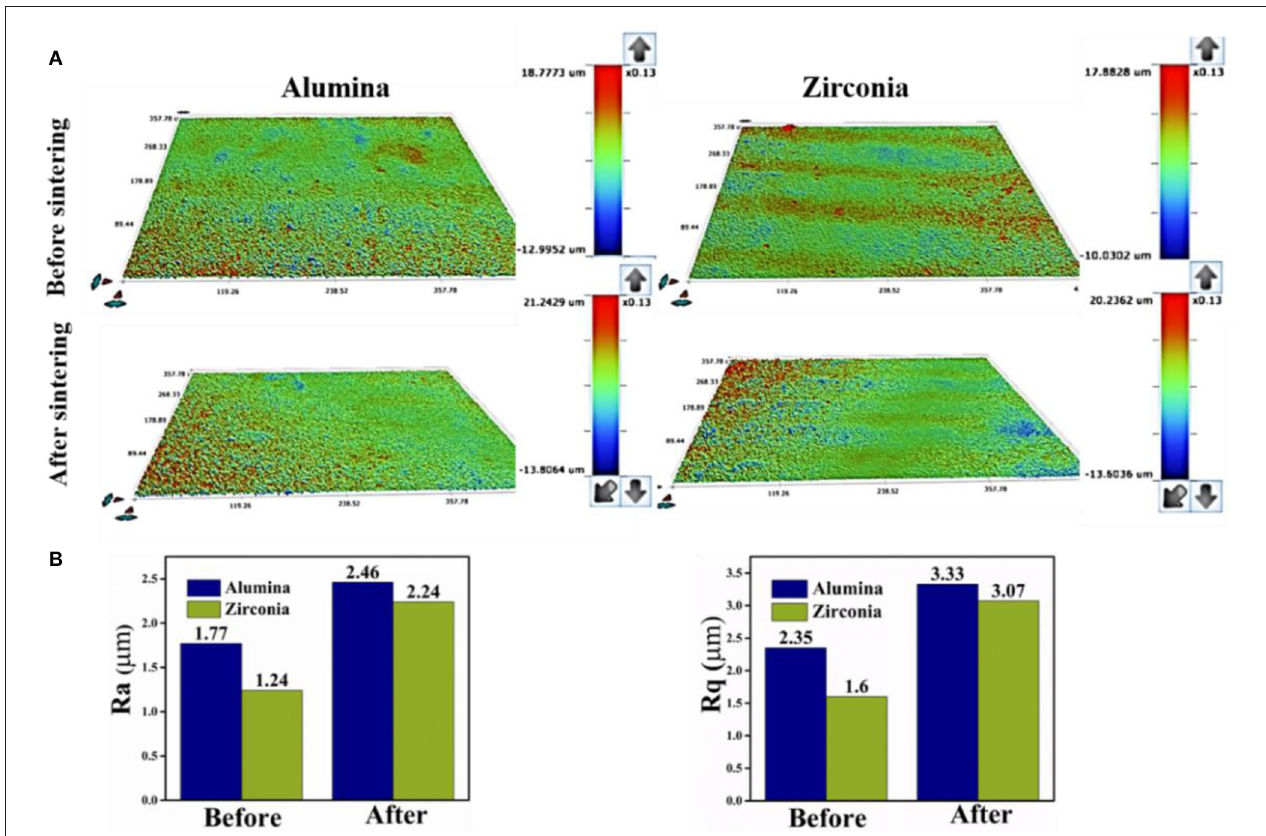
FIGURE 7 | (A) Optical surface profilometry of green machined alumina and 3YSZ before and after sintering and (B) average roughness (Ra) and root mean squared (Rq) roughness, before and after